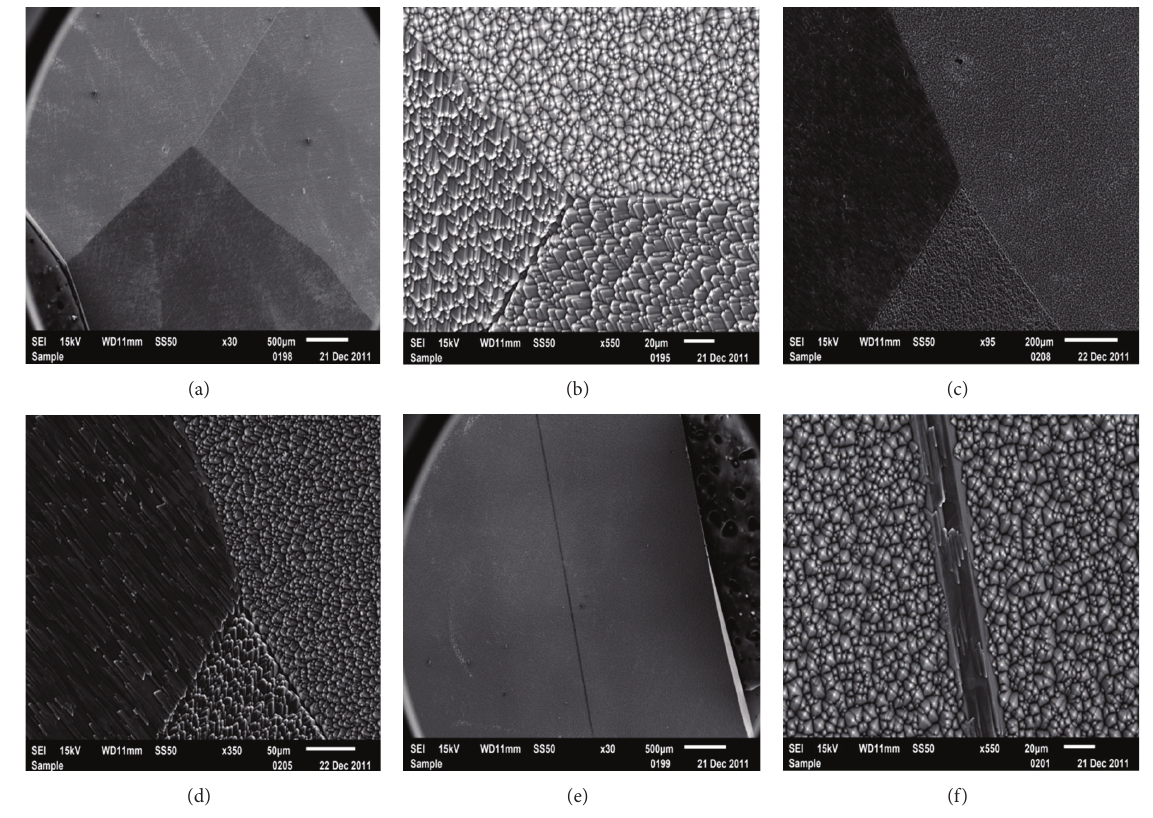
Figure 4: The pyramid topology shown by SEM at different locations within the wafer.